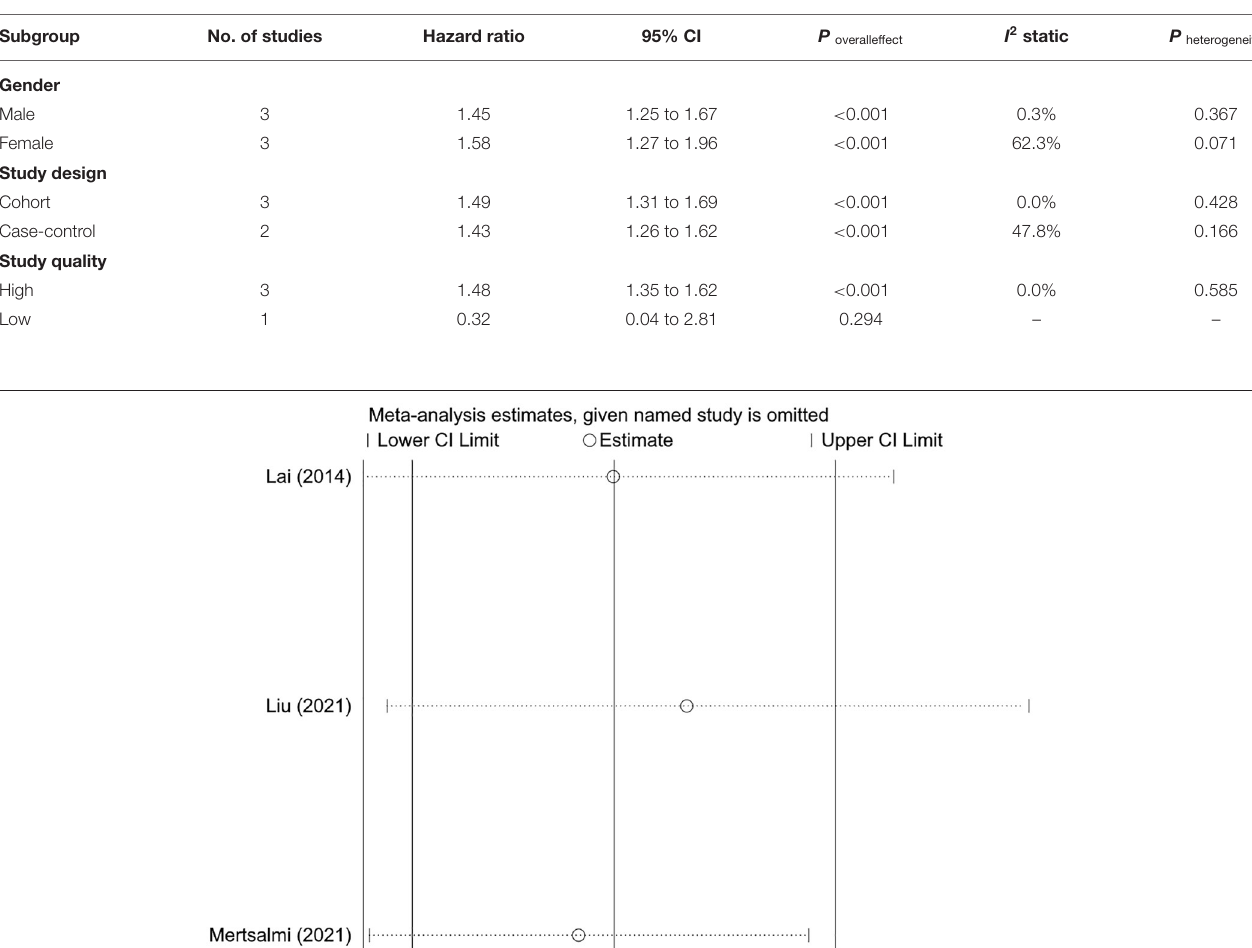
TABLE 3 | Subgroup analysis of the association between IBS and PD risk.